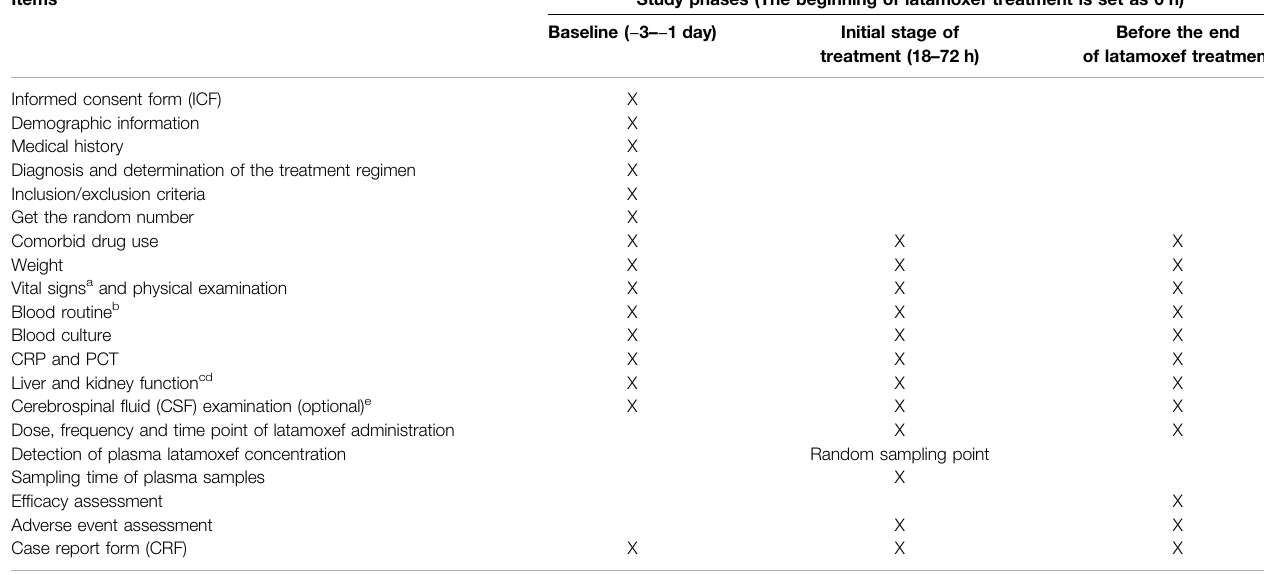
TABLE 3 | Study schedule of latamoxef RCT in EONS treatment. Items Study phases (The beginning of latamoxef treatment is set as 0 h) Baseline ( − 3 – − 1